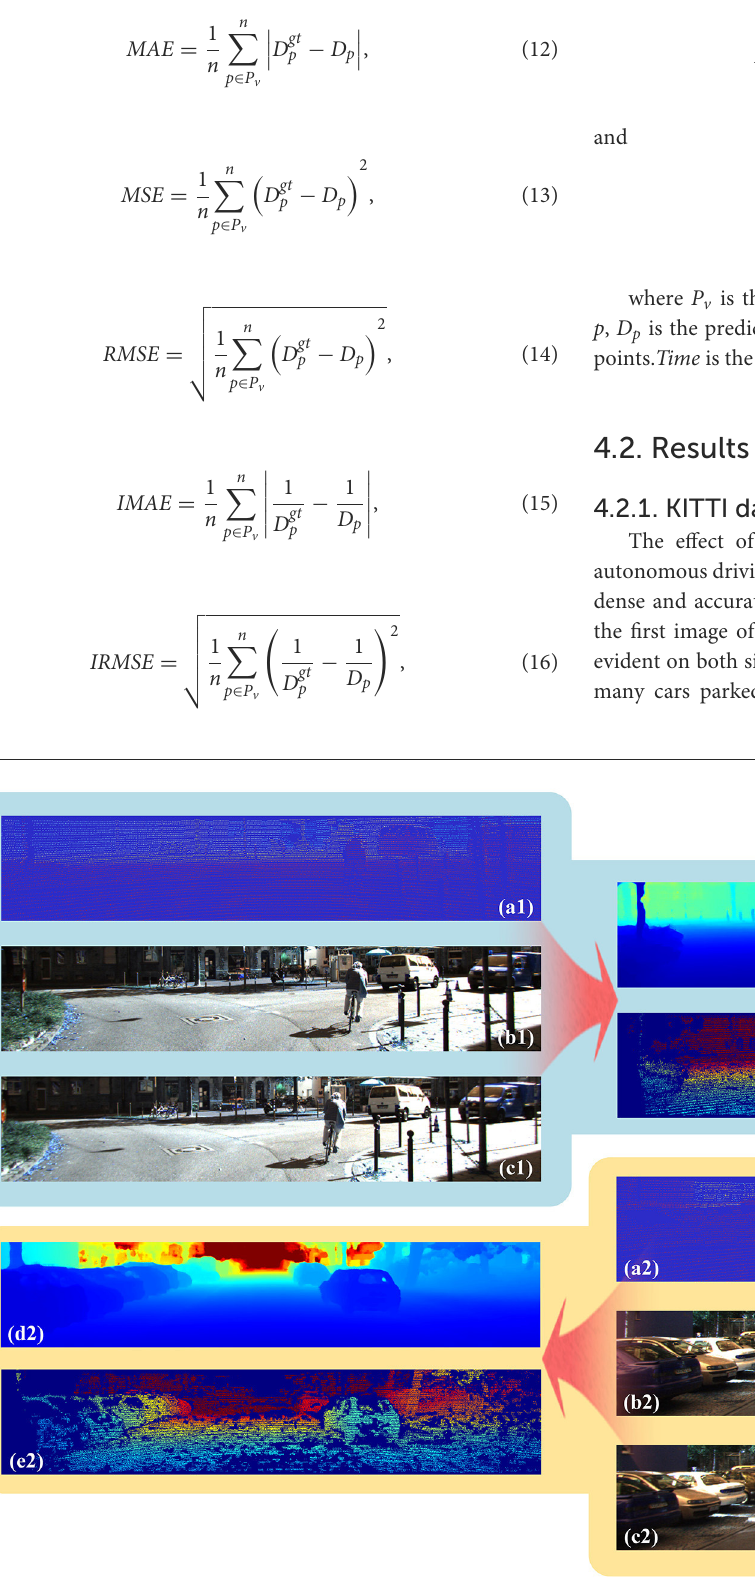
FIGURE5 Results of our network on KITTI. (a) is the sparse point cloud from the LiDAR, (b) is the left image of the binocular camera, (c) is the right image of the binocular camera, (d) is the dense depth image completed by our network, and (e) is the ground truth of the dense point